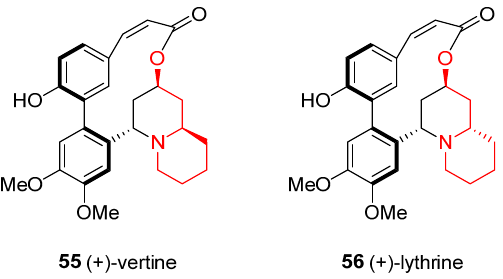
Figure 3. Structures of the alkaloids (+)-vertine and (+)-lythrine.